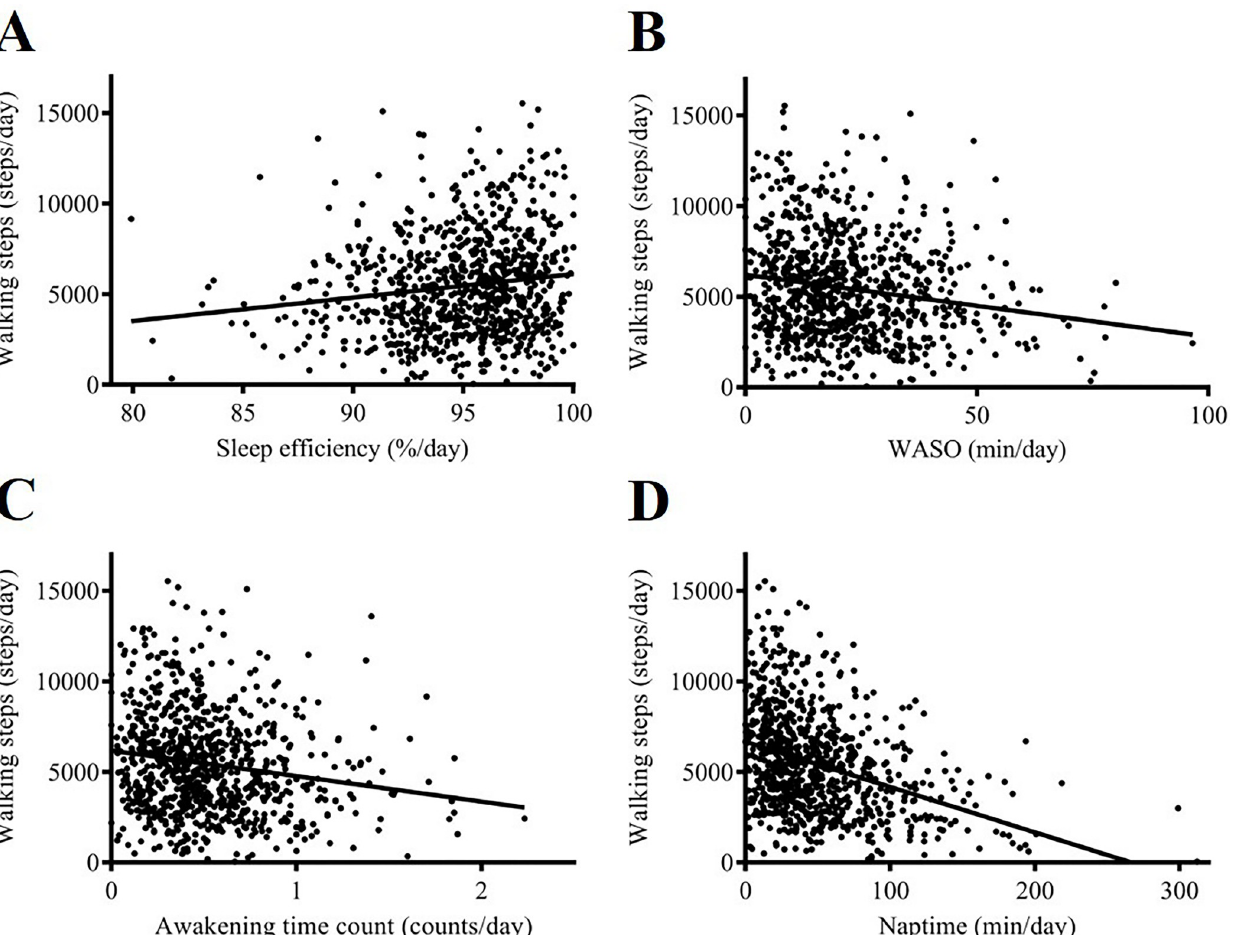
Fig 1. Association between daily walking steps and sleep parameters. Daily walking steps showed a positive correlation with sleep efficiency (A) and an inverse correlation with WASO (B), awakening time count (C), and naptime (D). WASO, time awake after sleep onset.